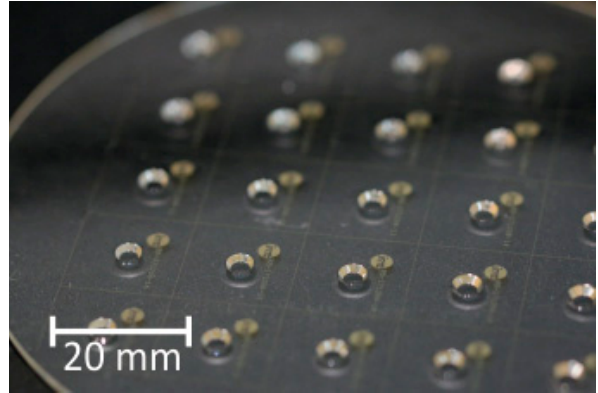
Table 1. Nominal wall slope 𝑆 given by CAD in comparison to measured values.